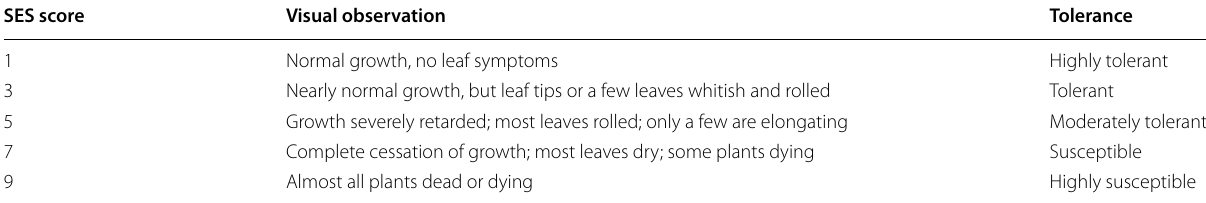
Table 1 Modified standard evaluation system (SES) score of visual salt injury at seedling stage SES score Visual